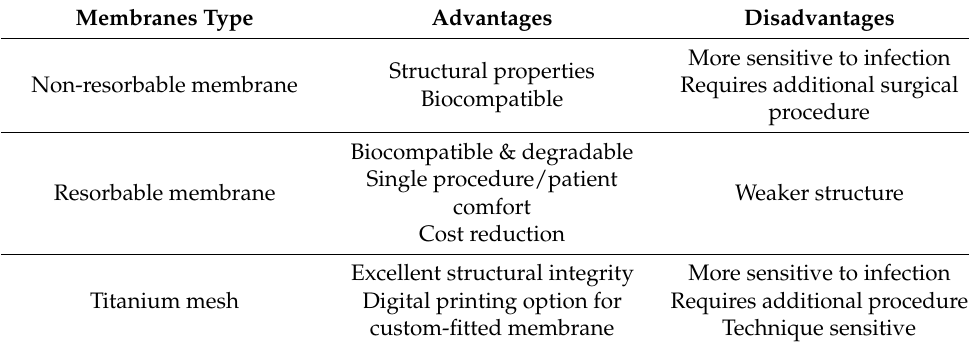
Figure 6. Classic horizontal ridge augmentation with a collagen resorbable membrane and xenogeneic grafting material mixed with autologous bone chips simultaneous to implant placement in the esthetic zone: ( a ) edentulous ridge, facial view; ( b ) edentulous ridge, incisal view; ( c ) soft tissue flap reflection with papilla sparing incisions where a horizontal defect was encountered; ( d ) implant placement and cortical perforation to allow for better blood supply to the graft, ( e ) horizontal ridge deficiency visible after implant placement; ( f ) bone xenograft + autologous bone chips (harvested form the nasal spine) and a resorbable collagen membrane placed and secured with strapping periosteal sutures; and ( g ) flap repositioned and secured with non-resorbable sutures. Table 1. Properties of biologic membranes and adjunctive